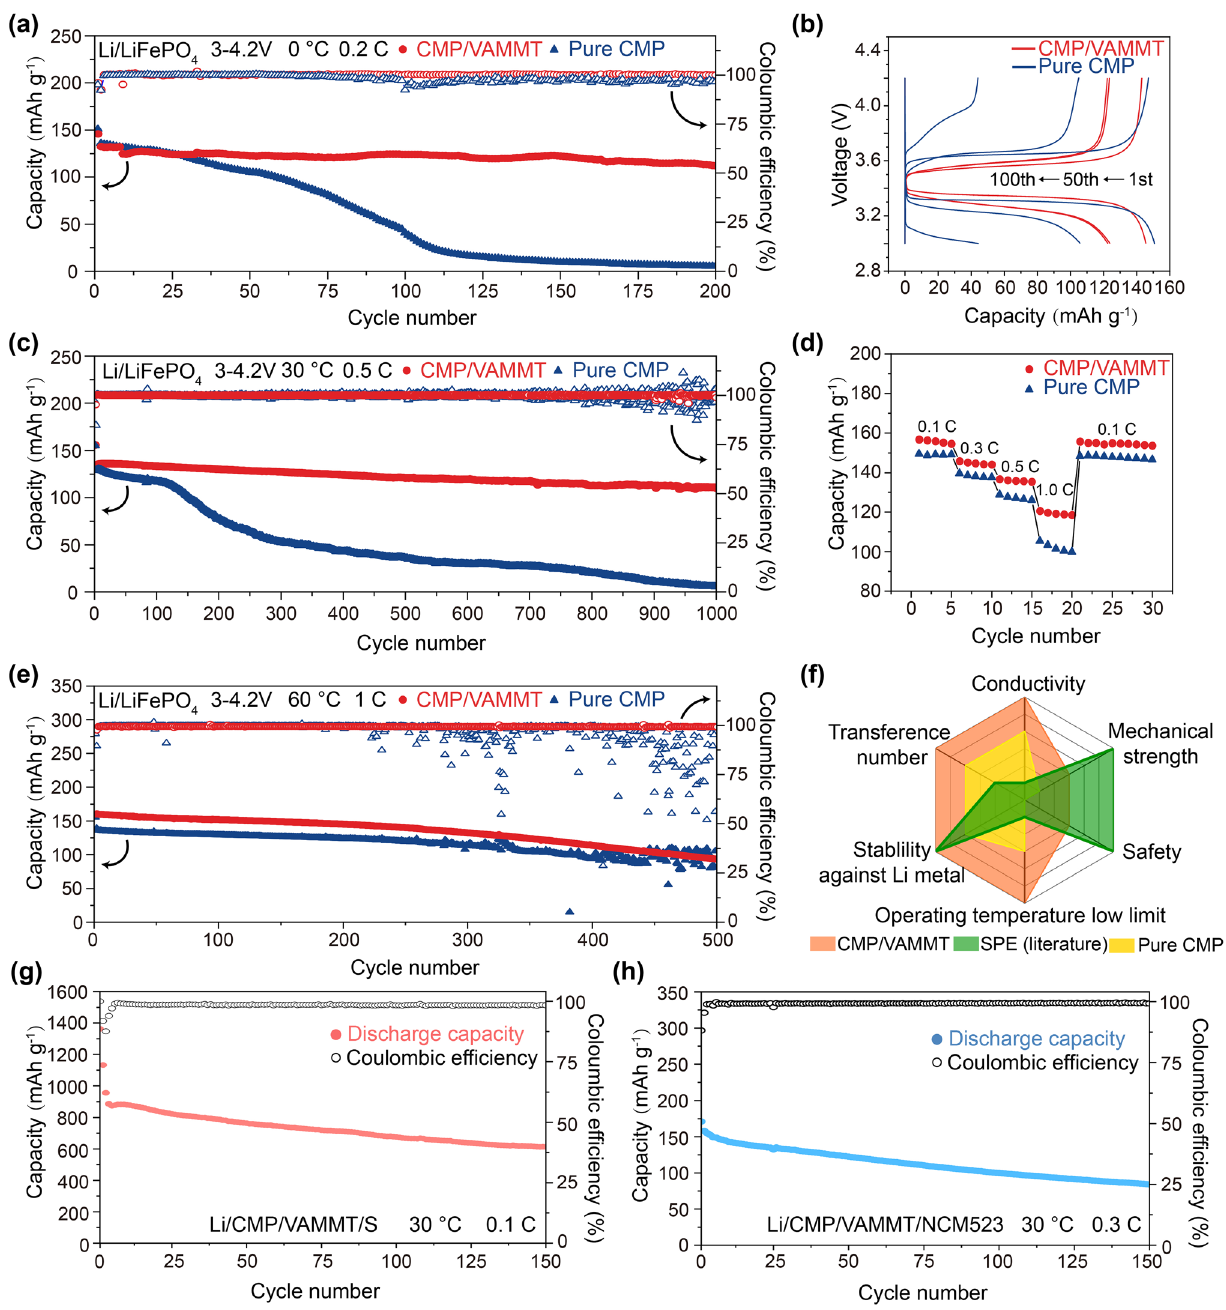
Fig. 6 Cycling performance of CMP/VAMMT in full cells. a Long cycle performance of Li/CMP/VAMMT/LFP cells at 0.2C, 0 °C. b Cor- responding voltage profile at different cycles in a). c Long cycle performance of Li/CMP/VAMMT/LFP cells at 0.5C, 30 °C. d Cycling perfor- mance of Li/CMP/VAMMT/LFP cell at different charging rates, cycled at 30 °C. e Long cycle performance of Li/CMP/VAMMT/LFP cells at 1C, 60 °C. f The performance of the CMP/VAMMT electrolyte compared with the pure CMP and SPEs reported in the literature. Cycle perfor- mance of g Li/CMP/VAMMT/S cells at 0.1C and h Li/CMP/VAMMT/NCM523 cells at 0.3C, 30